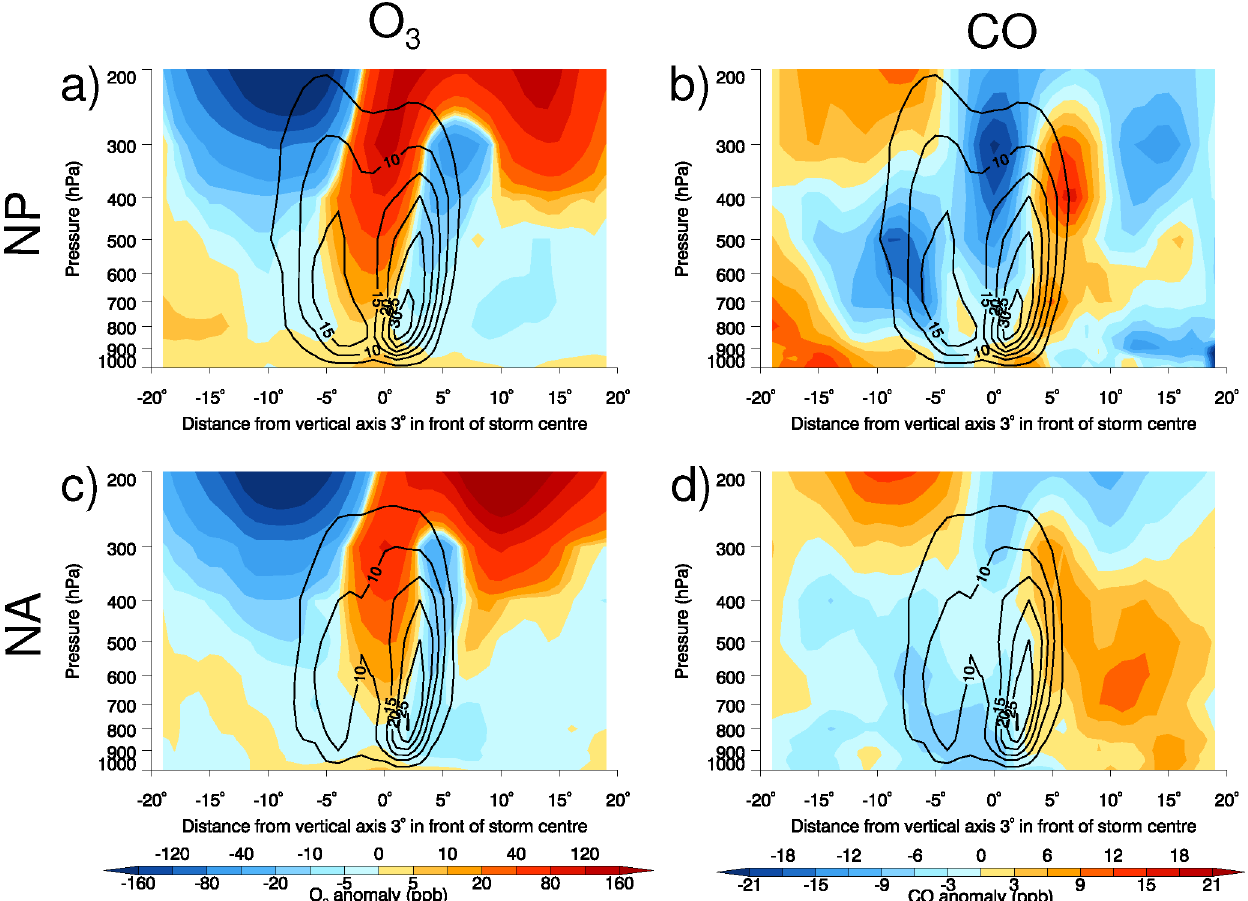
Figure 11. (a, c) O 3 and (b, d) CO anomalies (ppb) for WCB for storm-centered composites (Fig. 8) minus background composites for the 95th percentile MAM storm tracks during 2003–2012 for (a, b) NP and (c, d) NA. Solid contours are ω anomalies (5hPah − 1 contour